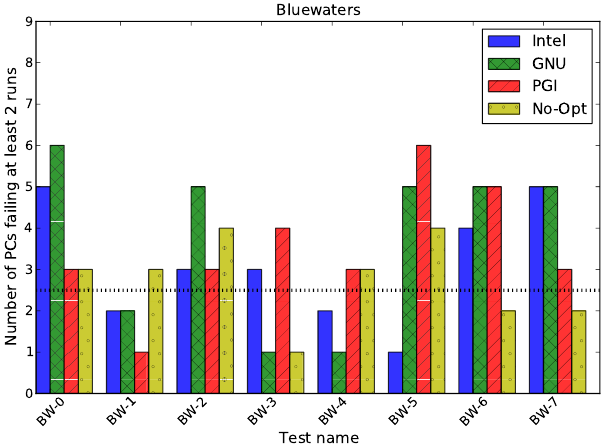
Figure 3. Additional CESM-ECT results on Bluewaters, comparing against four different ensemble distributions. Bars extending above the dashed line indicate an overall failure.